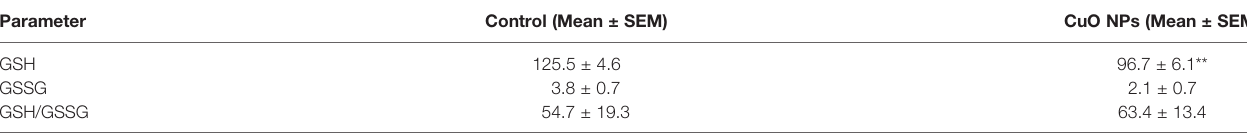
TABLE 4 | Antioxidant status, reduced glutathione and oxidized glutathione in the blood of mice after 6-week inhalation of CuO NPs.